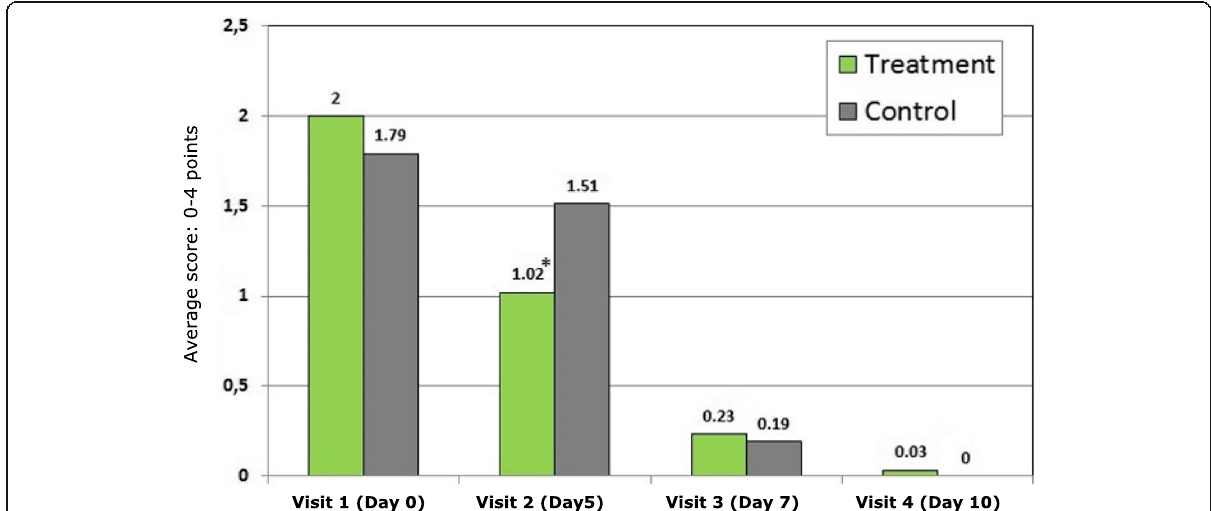
Fig. 3 Physicians ’ assessment of dynamics of the post-nasal drip symptoms (average score on the MSS scale: 0 – 4 points). * p < 0.05: Significant difference between groups